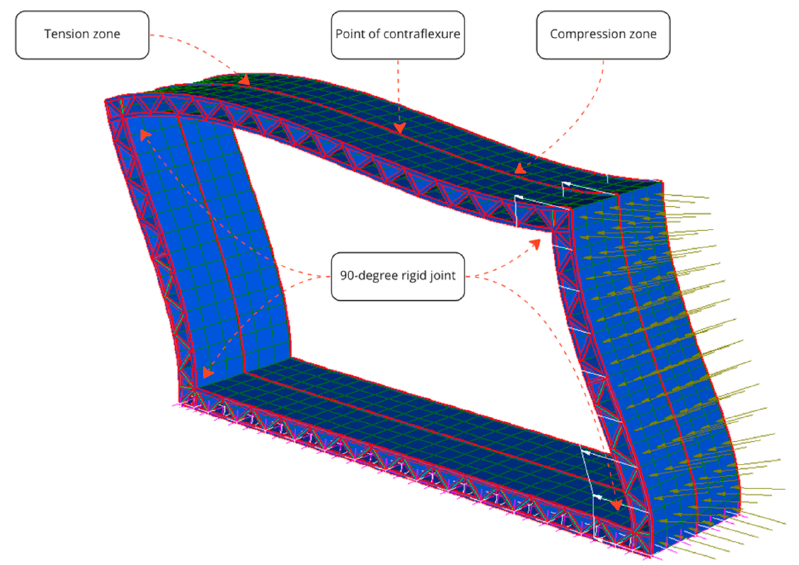
Figure 6. Deformed shape of DFF influenced by the wind load in the X direction.